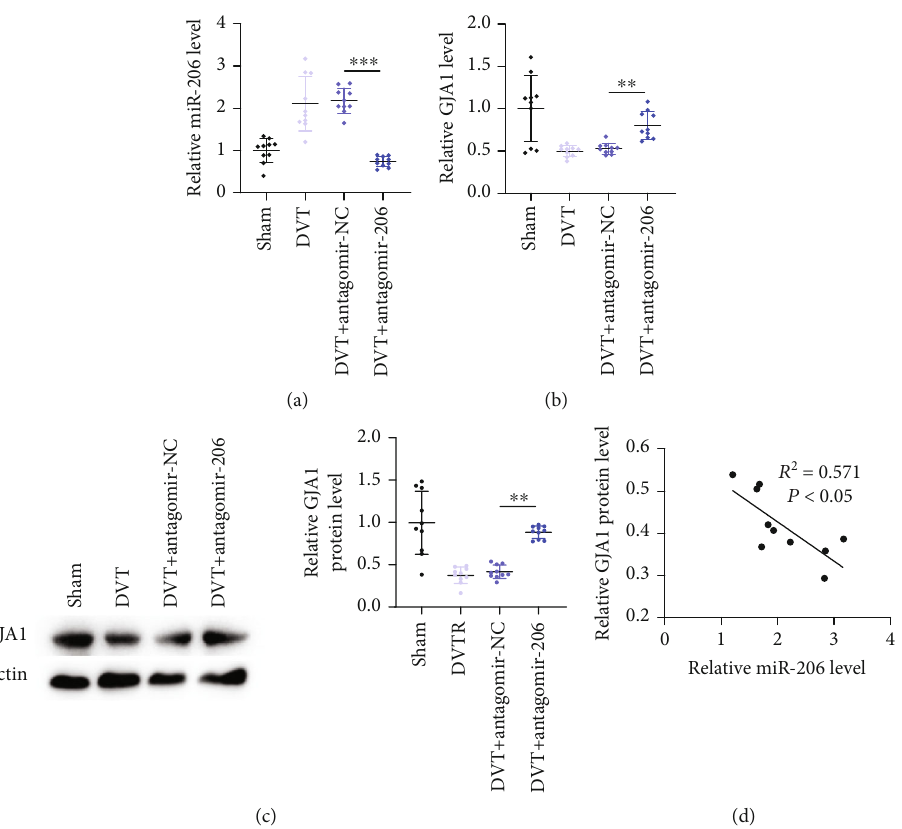
Figure 7: miR-206 negatively regulates GJA1 expression in vivo. (a, b) PCR analysis of miR-206 and GJA1 expression in vascular tissues of mice in Sham, DVT, DVT+antagomir-NC, or DVT+antagomir-206 groups ( n = 10 in each group) was assessed by RT-qPCR. (c) Western blotting analysis of GJA1 protein level in the above four groups ( n = 10 in each group). (d) Pearson correlation analysis of the correlation between miR-206 and GJA1 in vascular tissues of DVT mice ( n = 30 ). ∗∗ p < 0 : 01 and ∗∗∗ p < 0 : 001